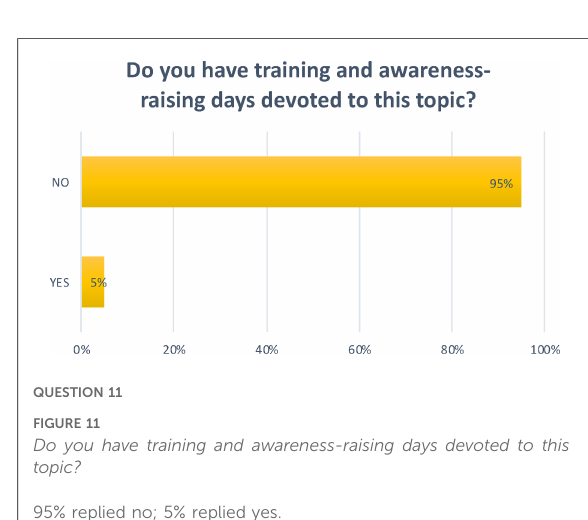
FIGURE 9 Can the food provided be de fi ned “ carioprotective ” , i.e., low in simple sugars? 85% replied yes; 15% replied no.